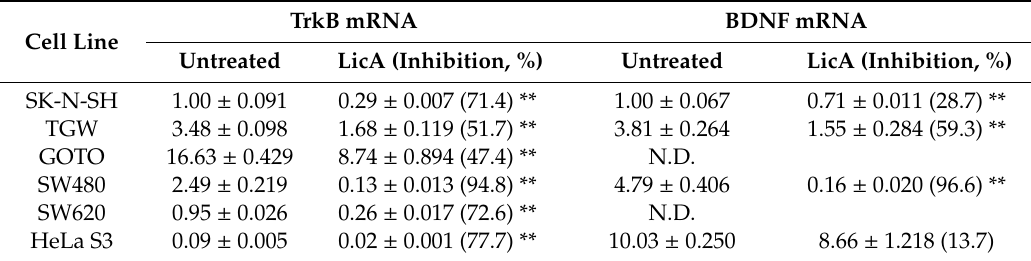
Table 2. Inhibitory e ff ect of LicA on hypoxic TrkB and BDNF mRNA levels of various cell